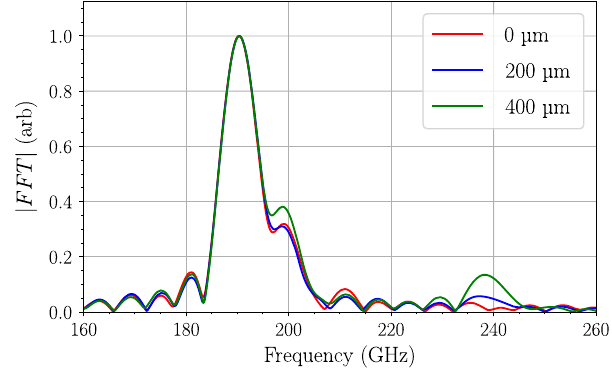
FIG. 14. Spectra normalized to the peak obtained during the horizontal translation sweep of the electron bunch